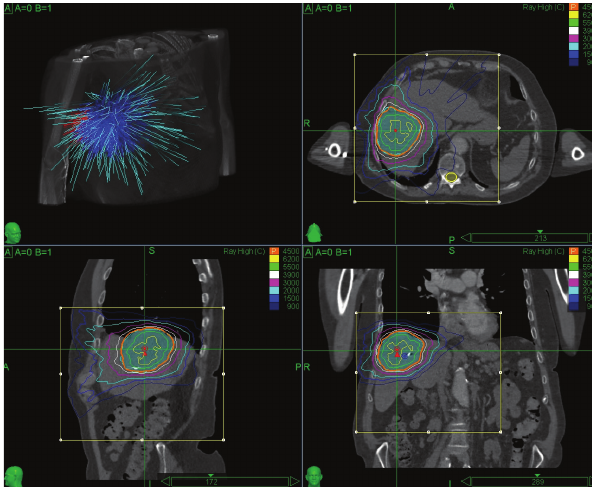
Figure 1: Image capture from stereotactic radiotherapy planning session, showing concentration of radiation dose to the tumor with much smaller but still significant amount of radiation delivered to the surrounding liver.